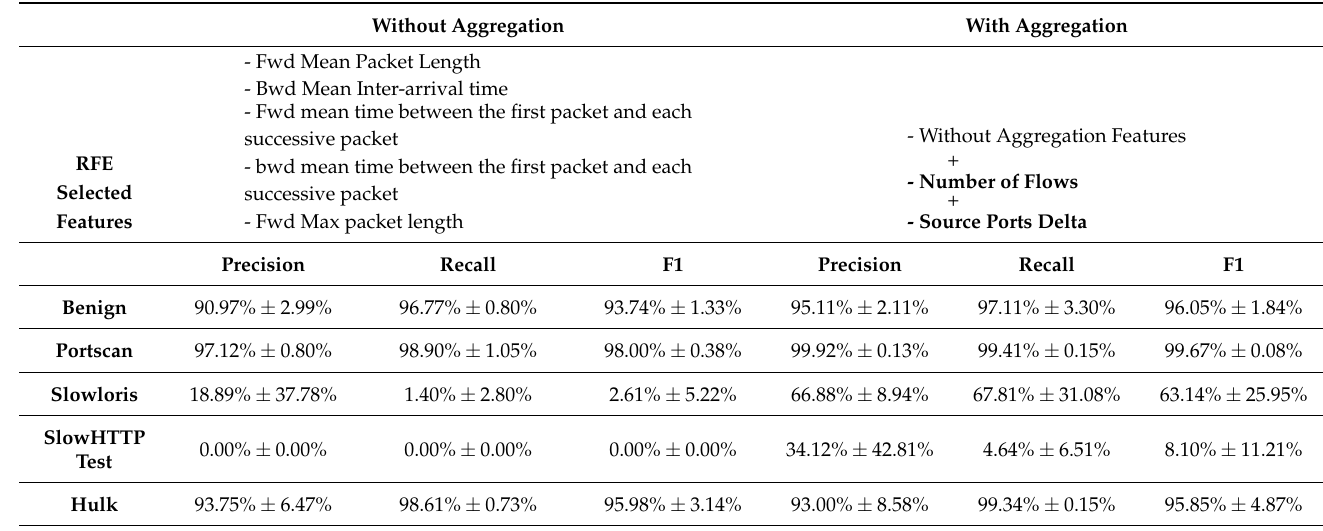
Table 11. Five classes classification (5-fold cross validation).